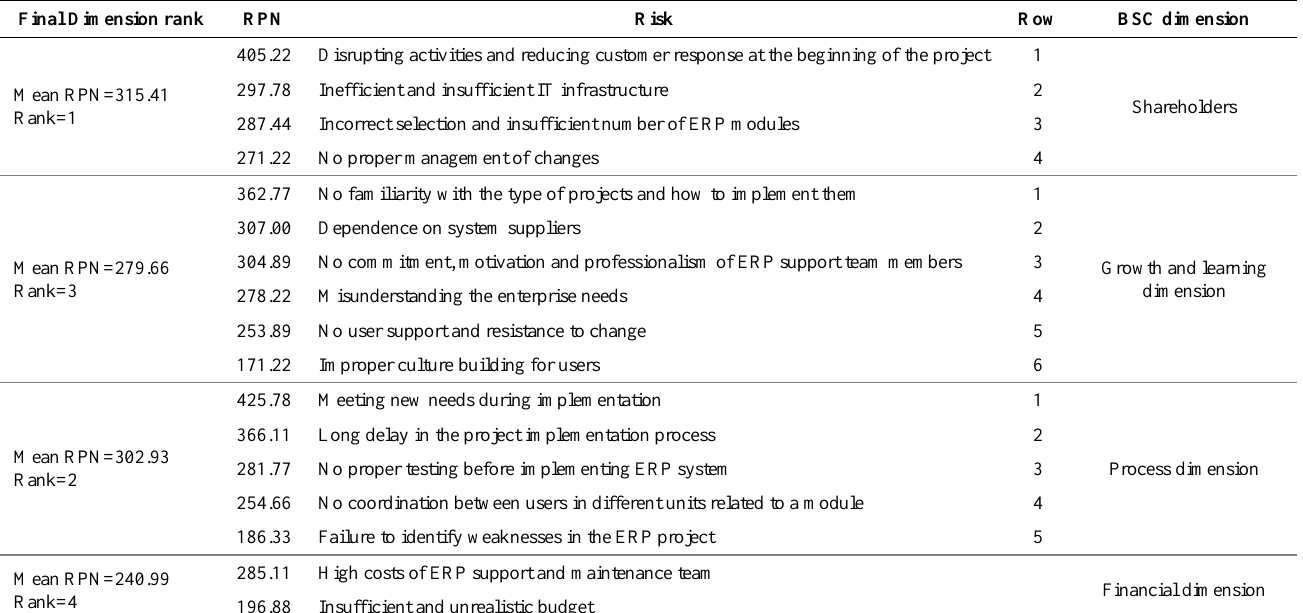
Table 2. ERP-related risks in the banking